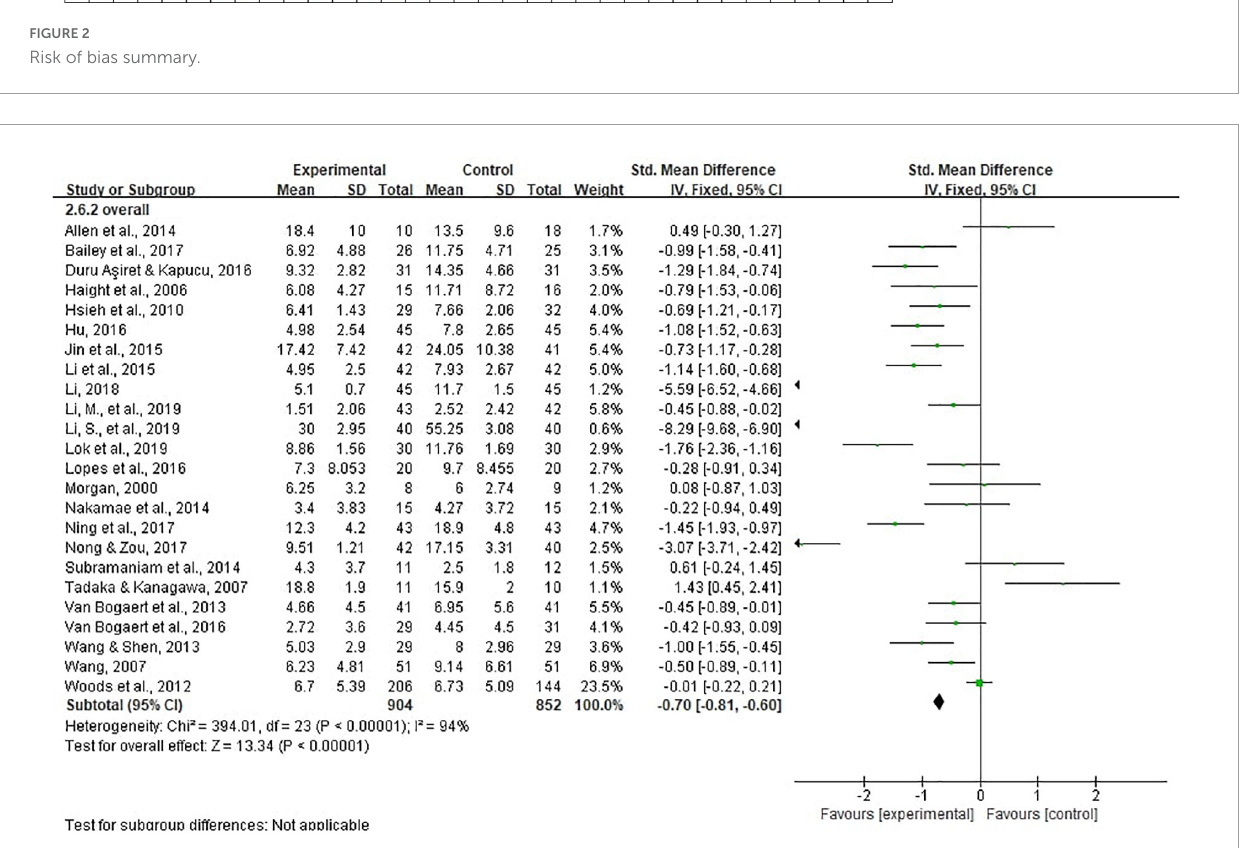
FIGURE3 Effect size of the intervention group versus the control group on depression rating scores.